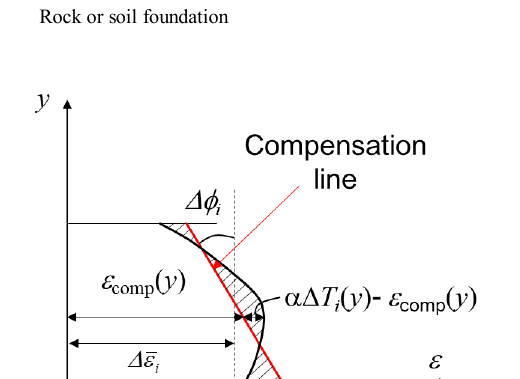
Figure 1. Compensation line.